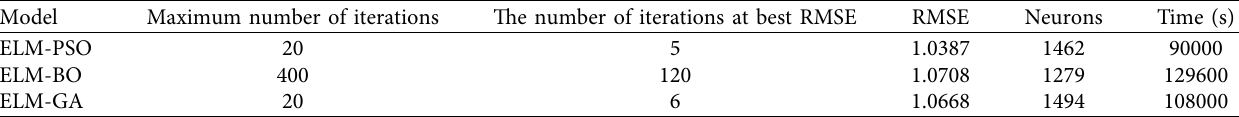
Figure 6: Convergence discriminant graph of PSO optimization. Table 2: The performance of each hyperparameter setting model.